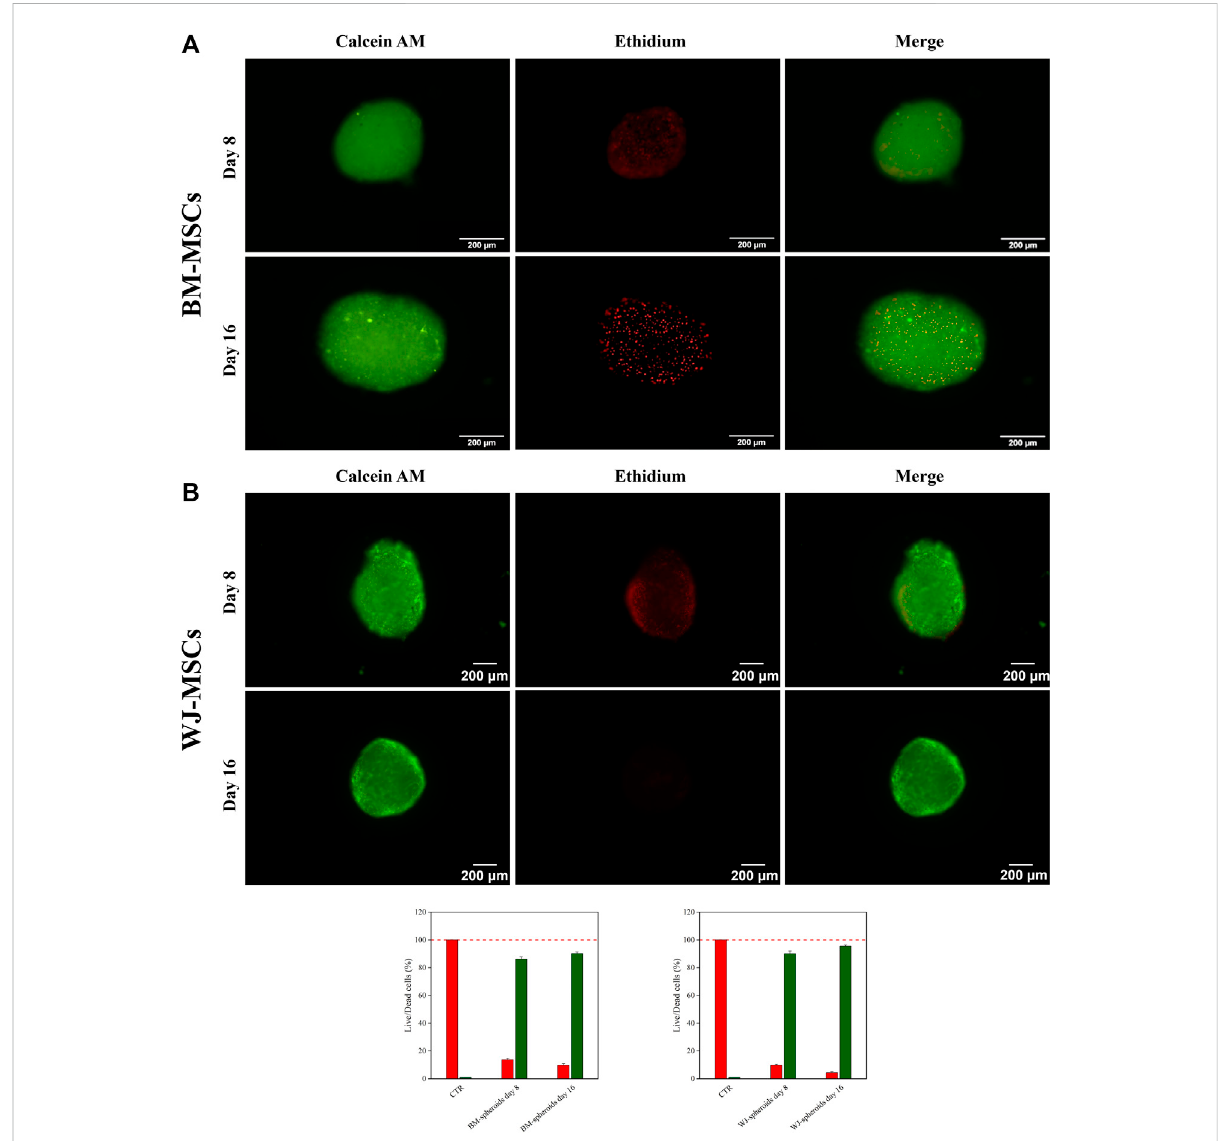
FIGURE 6 Live&Deadassayandquantify fl uorescentsignalofhBM-MSCs (A) andhWJ-MSCs (B) in3Dhigh-densityculturessupplementedwith10 ng/ml of hTGF- β 1 and acquired at Days 8 and 16. Viable cells appear green, non-viable cells in red. Scale bar: 200